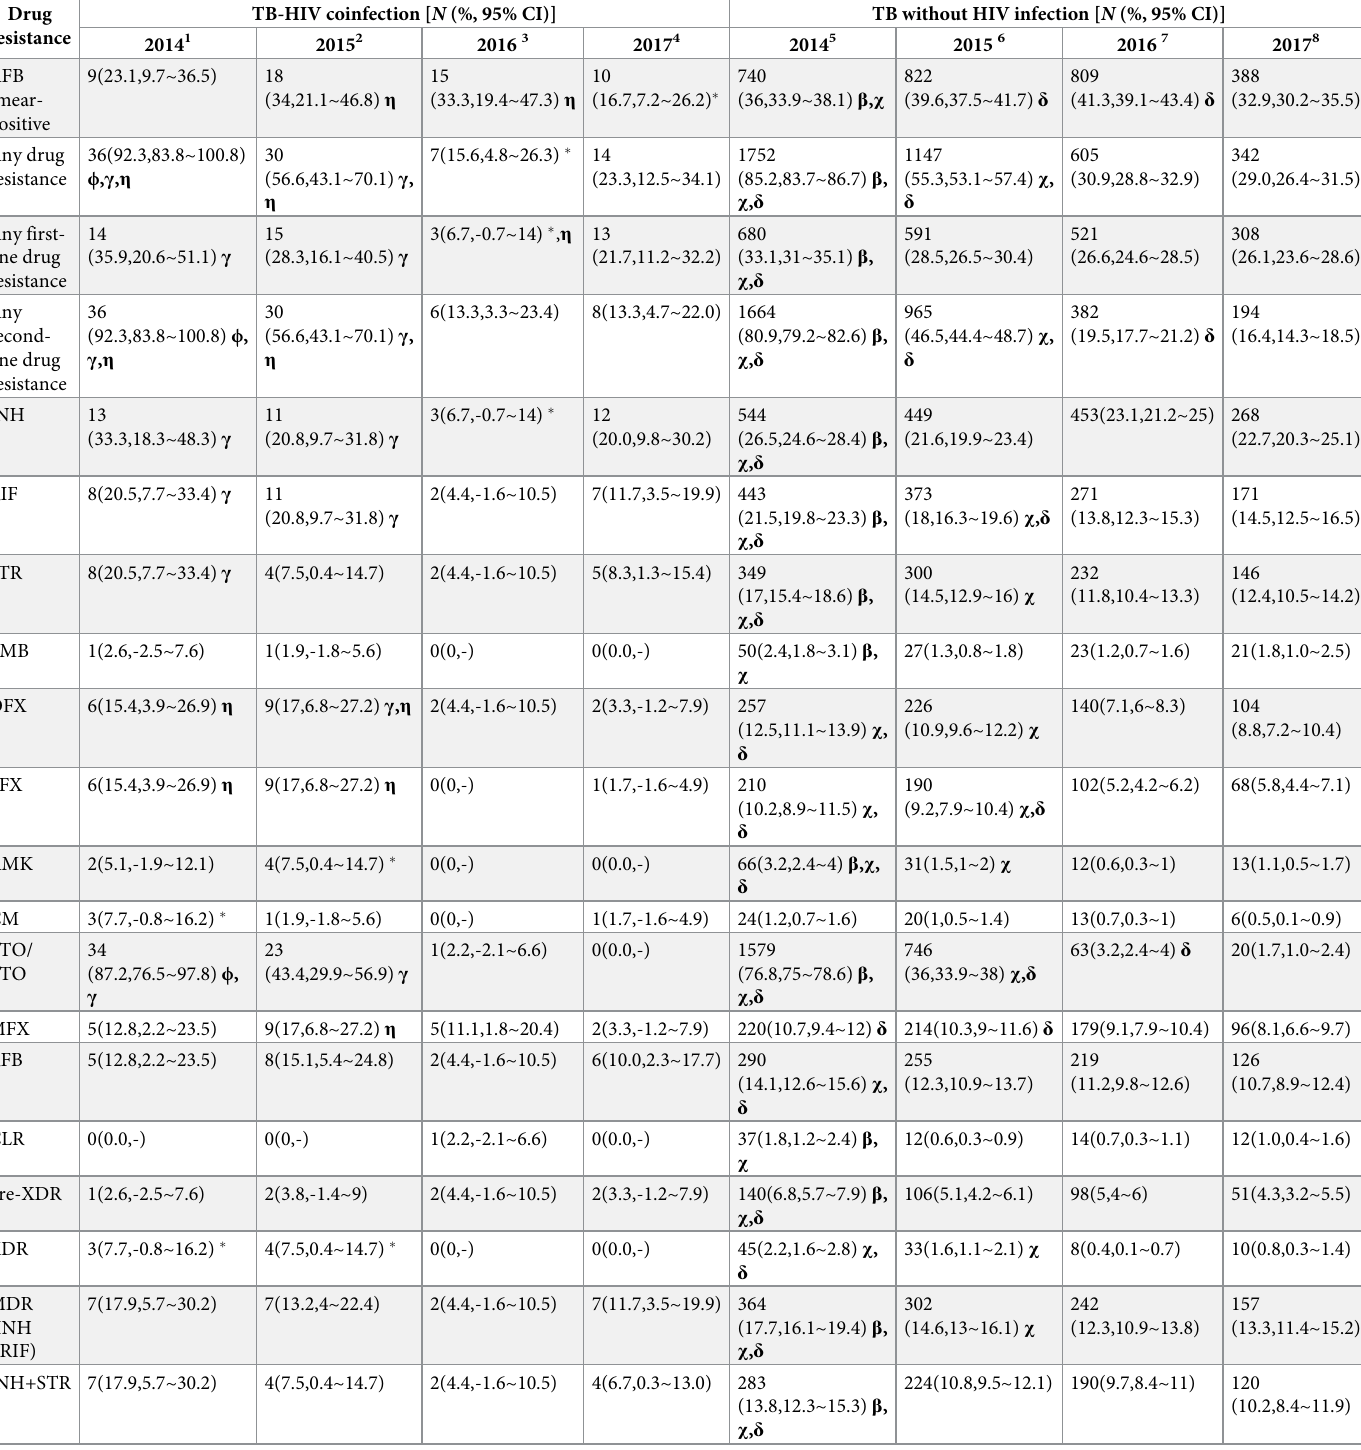
Table 3. Drug-resistant distribution of Mycobacterium tuberculosis isolates in different years. Drug